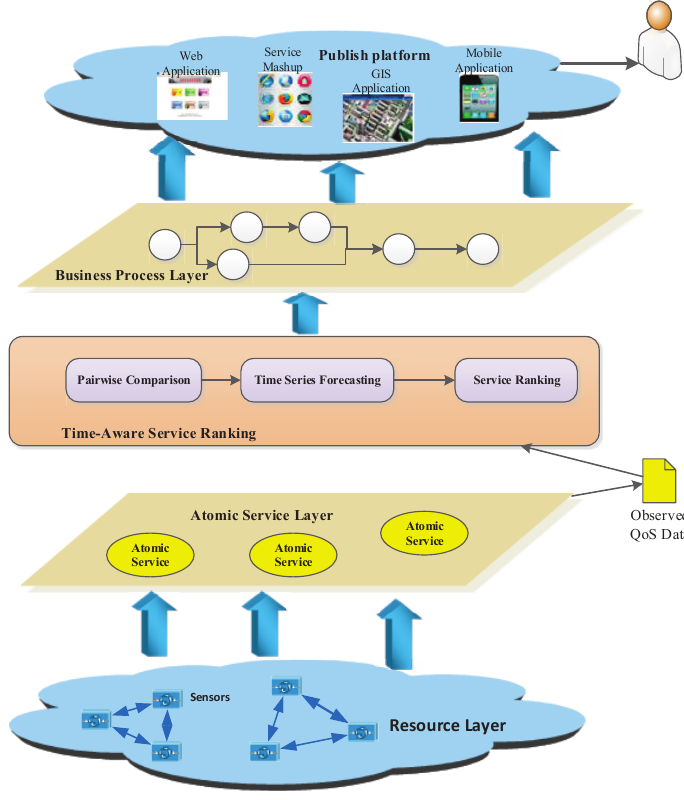
Figure 9. Framework of the prototype